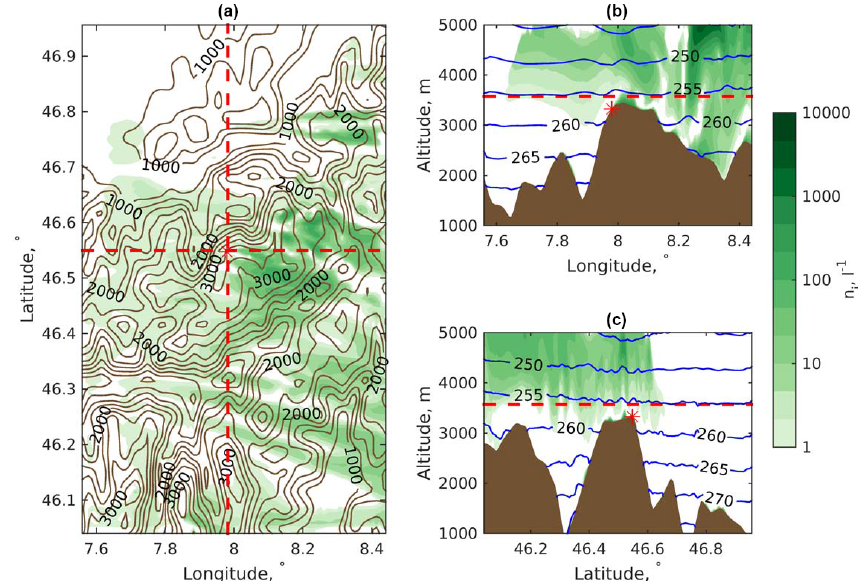
Figure 13. Ice number concentrations at 20:00UTC on 13 February 2014 from the WRF model simulations, including the addition of crystals from the surface crystal flux in three views. Panel (a) represents a horizontal cross section at the height of Jungfraujoch in reality (3570ma.s.l.), with the red dashed lines representing the vertical cross sections in panels (b) and (c) . Panel (b) represents an east–west vertical cross section at 46.55 ◦ latitude, with red dashed line indicating the horizontal cross section in panel (a) , and blue contours indicating isotherms in kelvin. Panel (c) represents a north–south vertical cross section at 7.98 ◦ longitude, with red dashed line indicating the horizontal cross section in panel (a) , and blue contours indicating isotherms in kelvin. In all three panels the location of Jungfraujoch is represented by the red star. The prevailing wind direction is north-westerly.